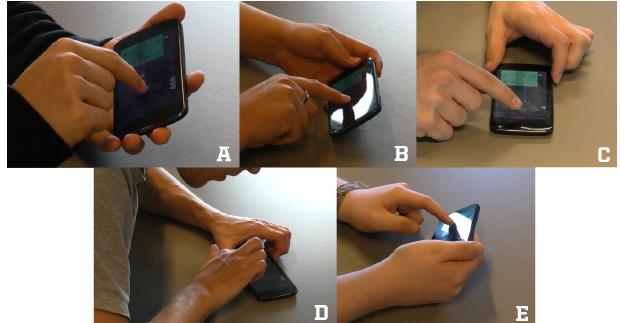
Figure 10. Different grip types of lab participants while dragging with their index finger in Wall Destroyer